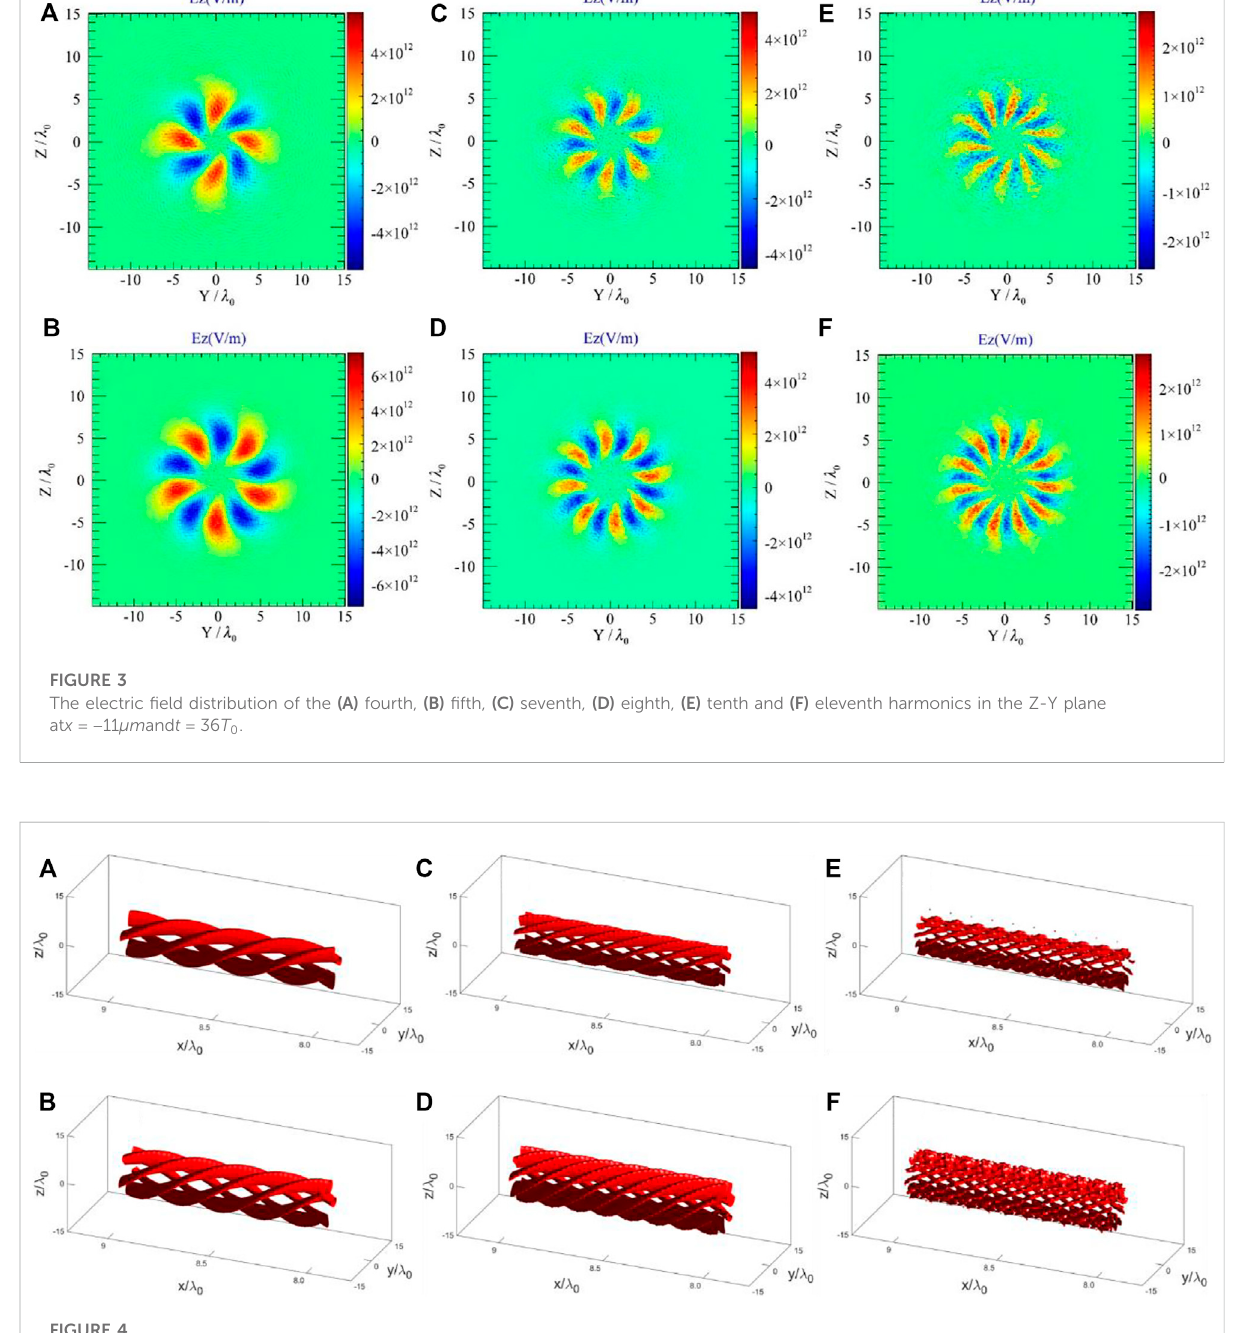
FIGURE 4 The electric fi eld isosurface of the (A) fourth, (B) fi fth, (C) seventh, (D) eighth, (E) tenth and (F) eleventh harmonics within a distance of 1 λ 0 in the propagation direction at t (cid:2) 36 T 0